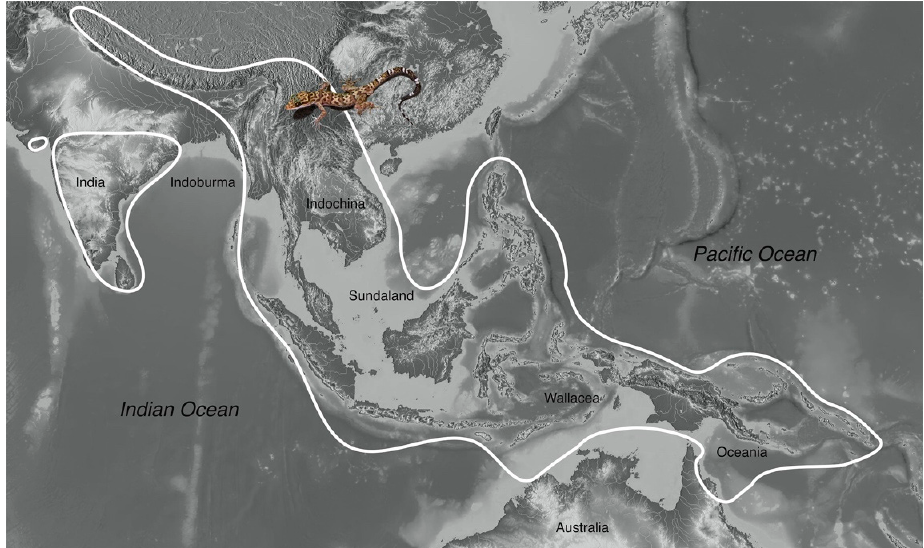
Figure 3. Generalized distribution of the genus Cyrtodactylus . Fig. 4 Ecotypes (JPEG Image, 3000 × 2512 pixels) — S... file:///E:/Manuscript/3.23-diversity-1173925-/final/图/F...